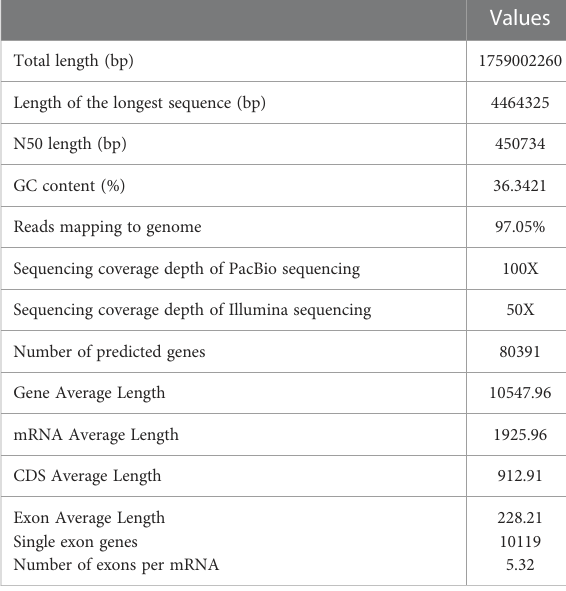
TABLE 1 Summary for genome sequencing, assembly and